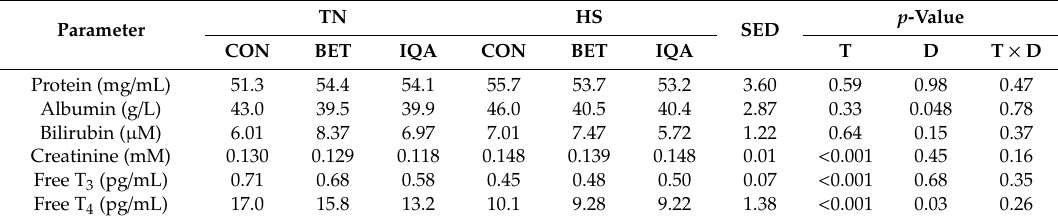
Table 3. E ff ect of thermoneutral (TN) and heat stress (HS) conditions and control (CON), betaine (BET) or isoquinoline alkaloids (IQA) diets on plasma biochemistry and hormones 1 .